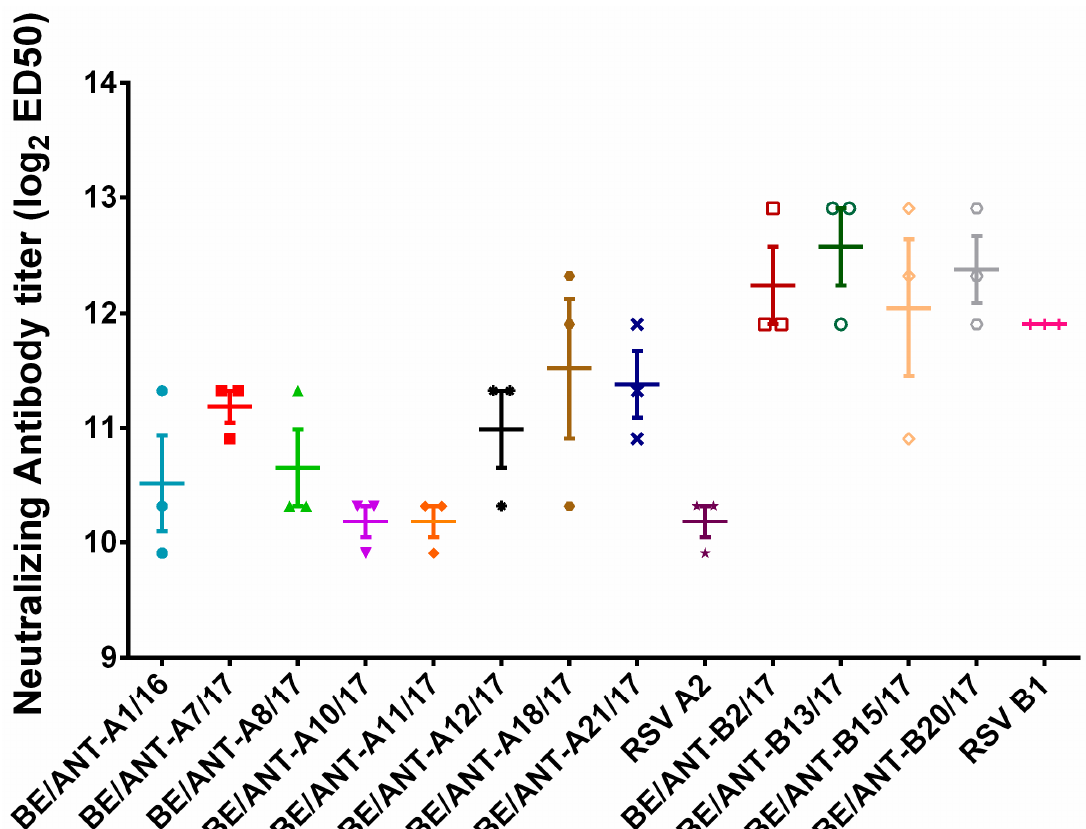
Figure 7. Plaque reduction of the clinical isolates with palivizumab. HEp-2 cells were infected for 2h with clinical isolates and reference strains that were pre-incubated for 1h with a palivizumab dilution series. Inoculum was replaced with DMEM-10 containing 0.6% Avicel ® and incubated for three days at 37 ◦ C. Afterwards, the cells were fixed, stained with palivizumab as primary antibody and goat-anti-human conjugated with HRP, plaques were visualized with chloronapthol. Individual values are plotted as 2log ED50, data represents mean values ± SEM ( n = 3).